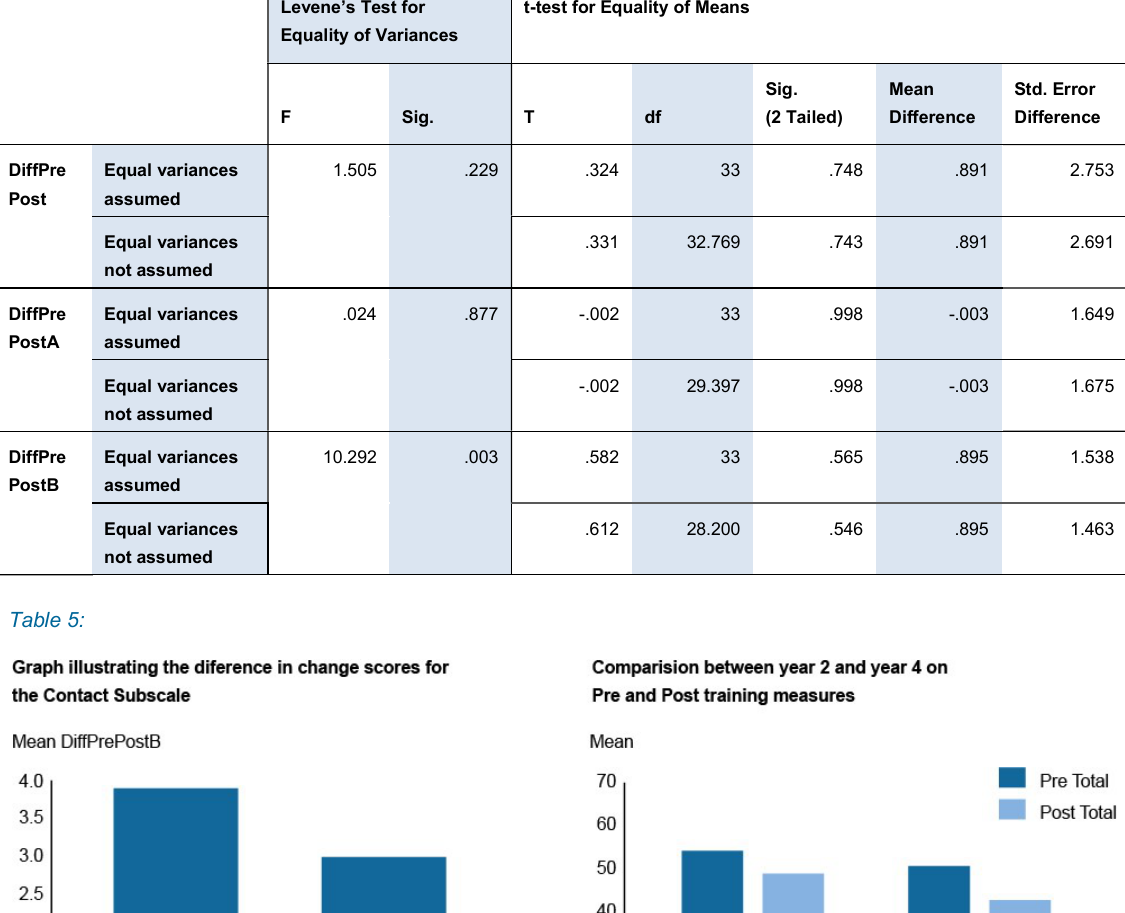
t-test for Equality of